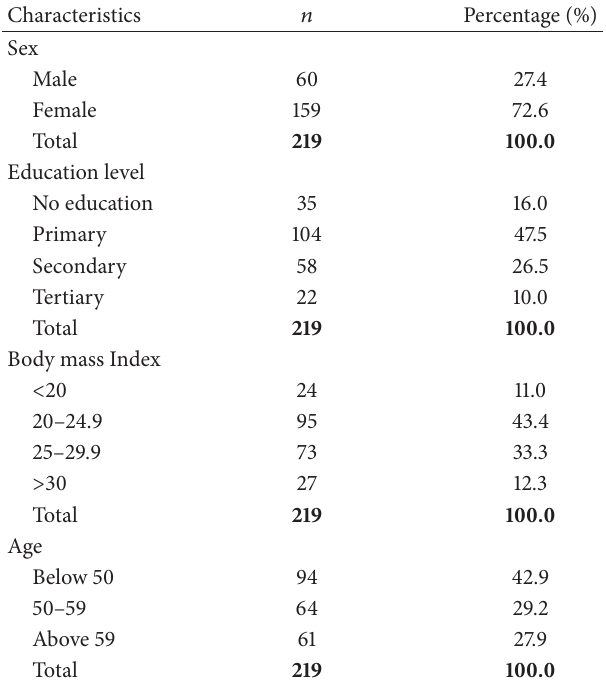
Table 3: Distribution by life style